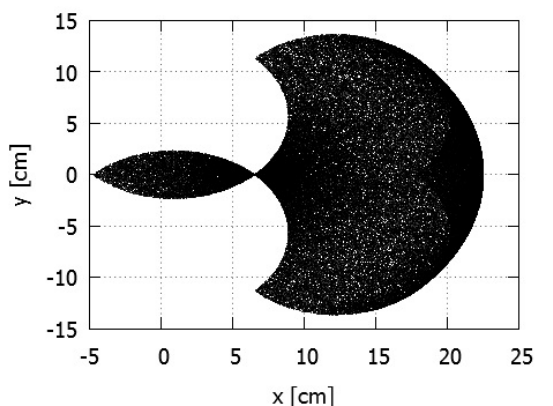
Figure 5. The theoretical movement range of the vertical plane of the arm of the designed robot. The system is capable of moving ± 13.66 cm along the z axis and 22.54 cm along the x